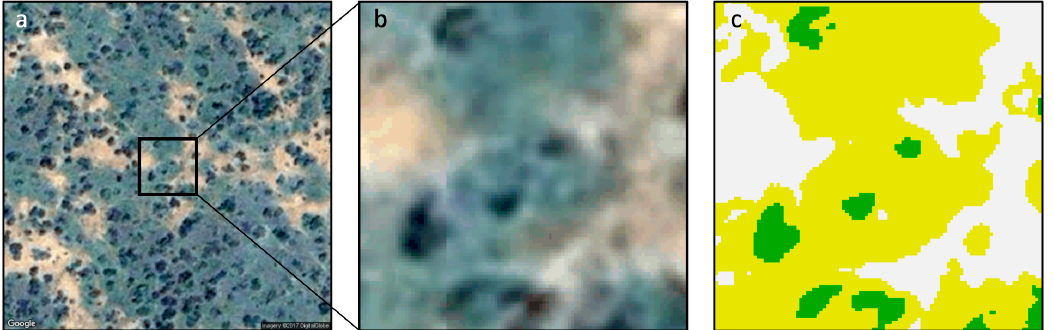
Figure 2. Example of reference data generation. For each reference point, we downloaded a 180 × 180 m scene from Google Earth imagery ( a ) centered on the 30 × 30 m Landsat pixel (inset of a ; b ). We then mapped the woody cover (green), grass (yellow), and soil (white) of the pixel ( c ). The percent woody cover was then extracted to generate the reference data. All reference data is available online: